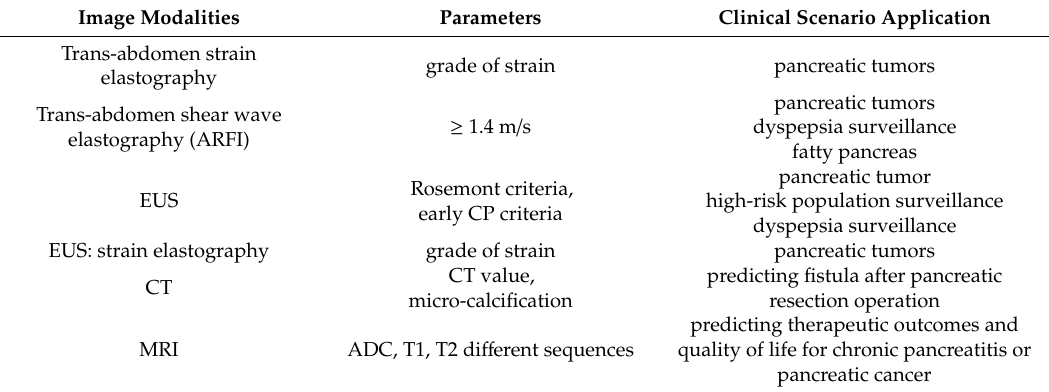
Table 1. Various image modalities for the non-histologic diagnosis of pancreatic fibrosis and clinical